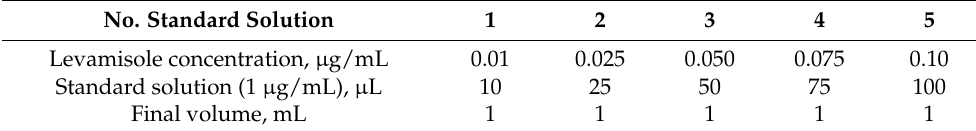
Table 1. Preparation of standard